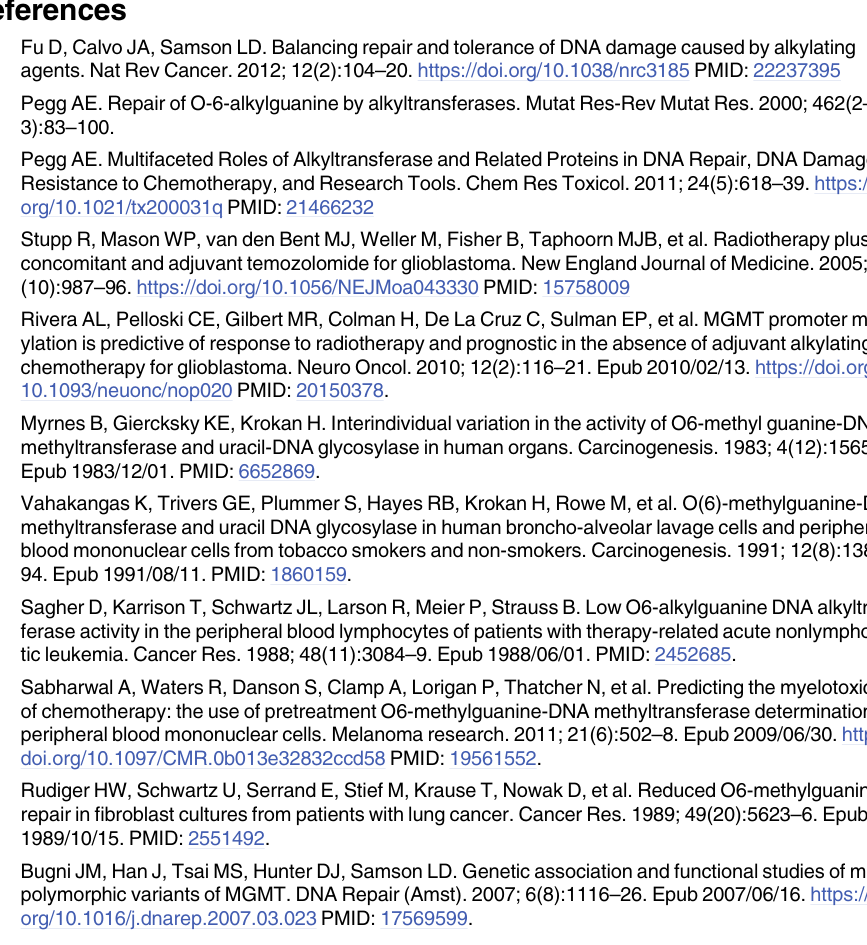
S2 Table. Pairwise statistical comparisons. Cell lines that were significantly different from one another for each MGMT assay are indicated with an asterisk “ � ”; those that were not sig- nificantly different are marked